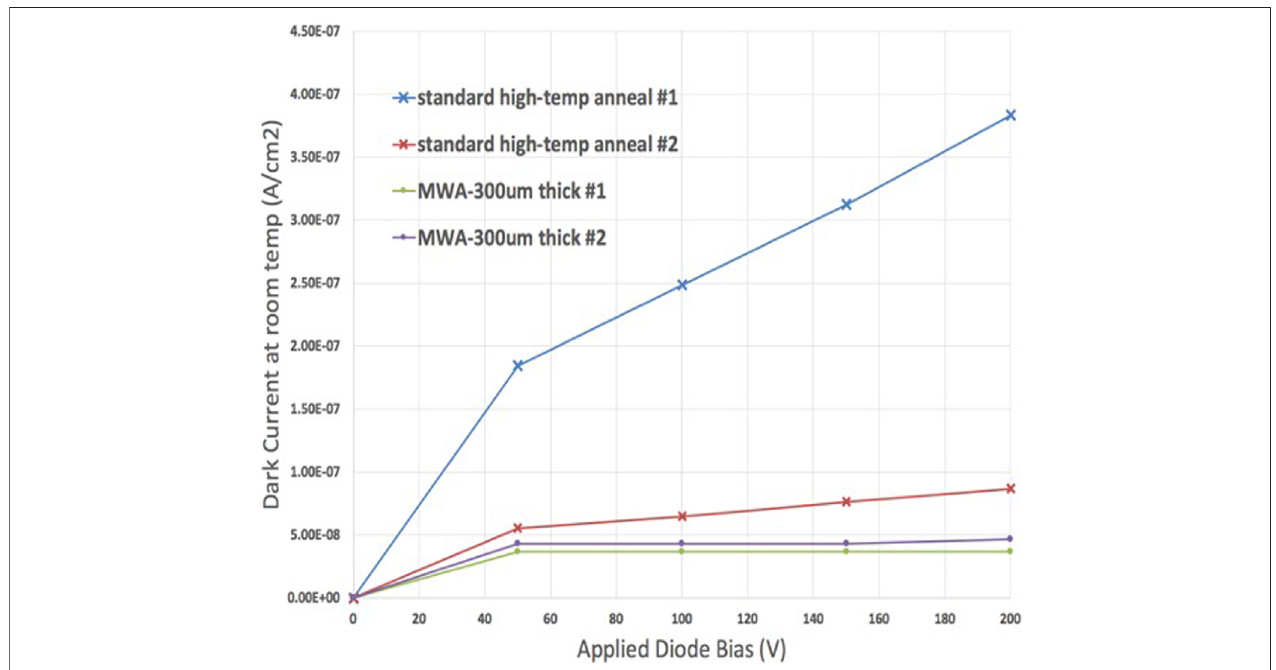
FIGURE 4 | Dark current measured on PIN diodes test structures with conventional anneal and microwave anneal. The microwave annealed sensors have comparable dark current based on this small sample of typical devices.